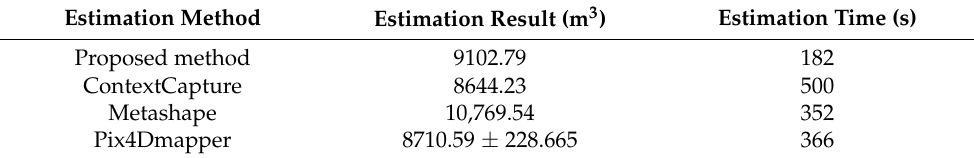
Figure 6. Results of 3D reconstruction and bottom-surface interpolation of landslide deposit. Table 1. Comparative analysis of estimation accuracy and efficiency.